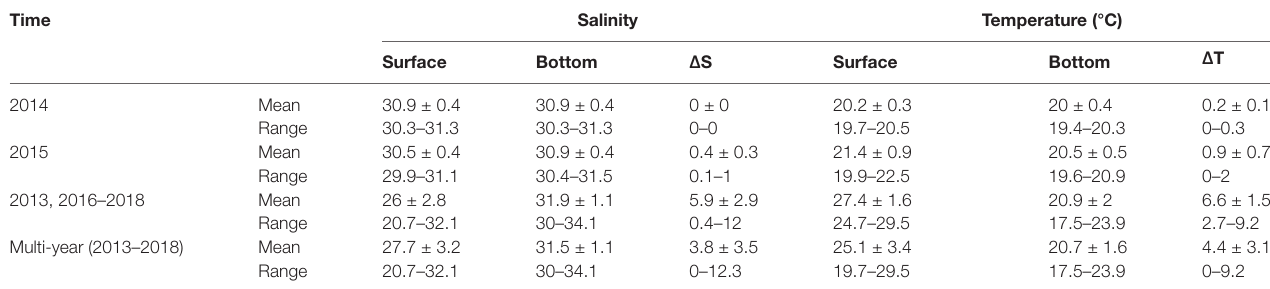
TABLE 1 | Mean, standard deviations, and ranges of salinity and temperature at surface, bottom, and the absolute difference between surface and bottom measured at sites in the CWZ (122.5°E–124°E, 31.5°N–32.5°N).